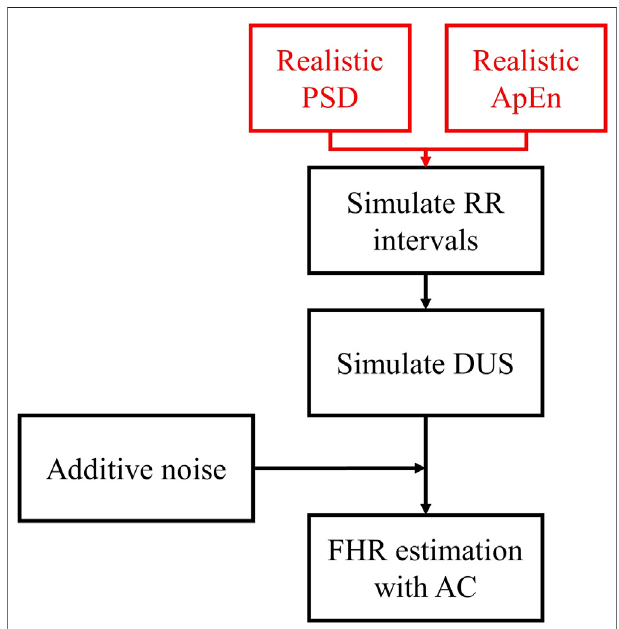
FIGURE 1 | Diagram of the simulation of FHR RRI and FHR DUS signals. The PSD and ApEn distributions reported by Gonçalves et al. (2013) are used to generate random simulations of FHR RRI with similar fHRV. Then, we simulate DUS signals that correspond to the FHR RRI and we add noise. Finally, we use the AC to estimate the FHR DUS